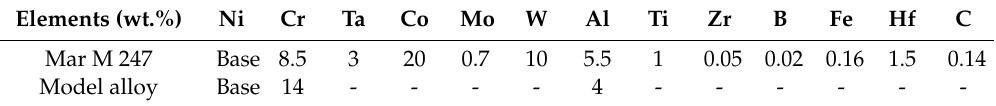
Table 1. Nominal chemical composition of investigated alloys in the as-cast condition (given in wt.%). Elements (wt.%)